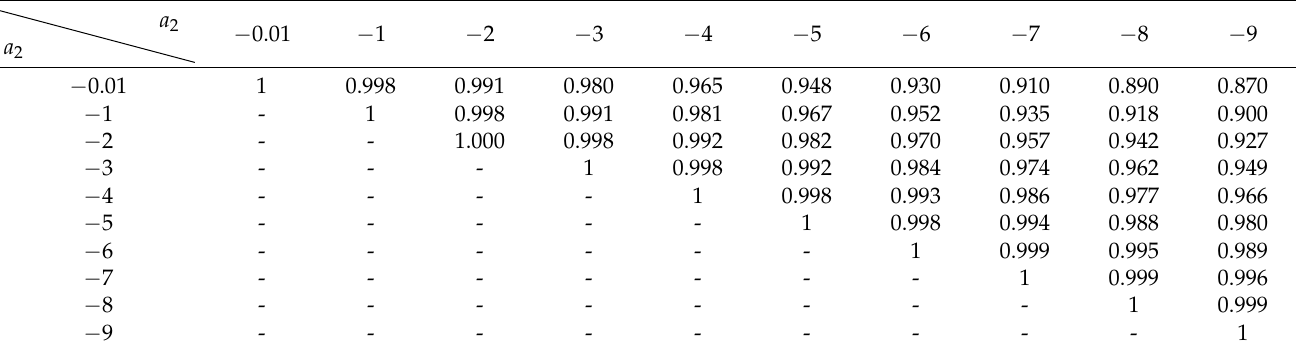
Table 2. The PCCs between different vectors of G 1 ( a 2 )